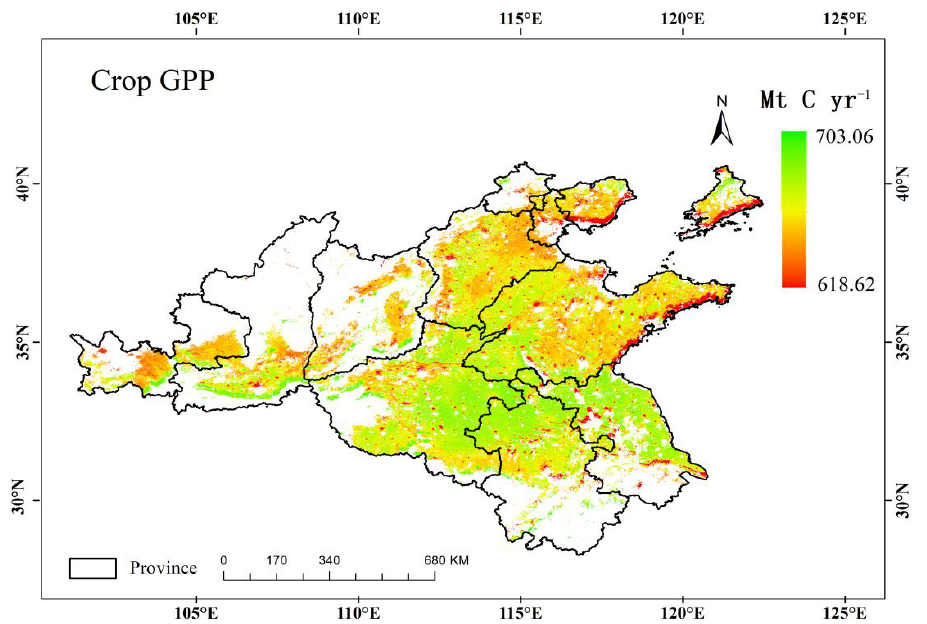
Figure 4 . The spatial distribution of cropland GPP in the North China Plain.